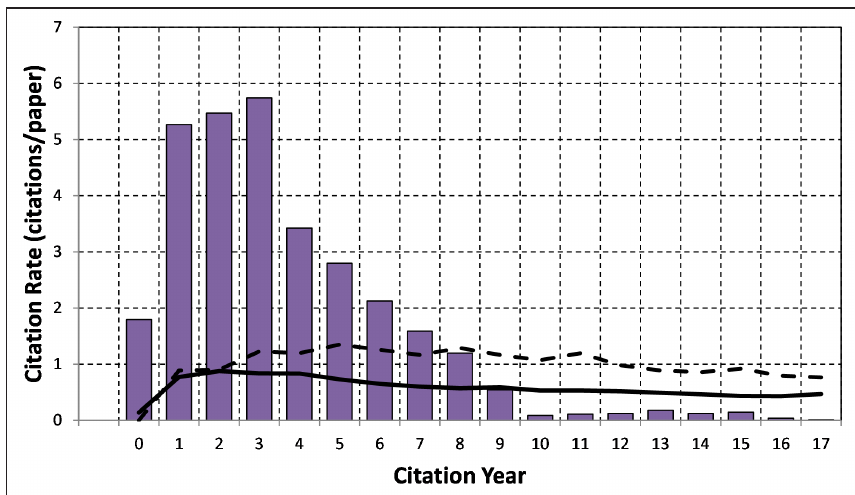
Figure 2: A normalized comparison of the modern Year-2000 citation histories (N = 26,020, solid line) with an earlier Year-1961 study by Abt (1981: N = 326, dashed line) and the normalized citation rate for the current CS sample (N = 143, bars) obtained by summing over the individual project profiles in Figure 1.